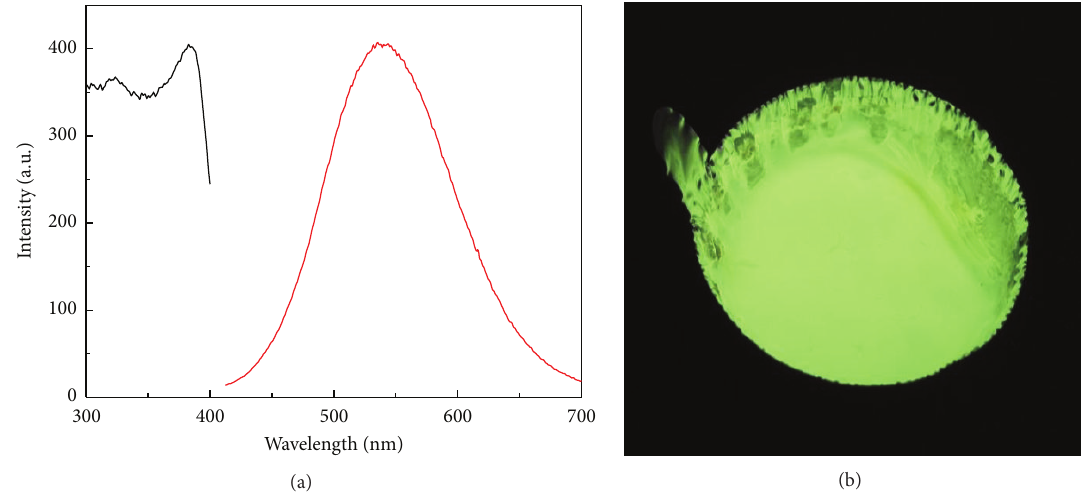
Figure 5: Polystyrene-embedded AuMMI clusters: PL spectrum (a), and sample (3% by weight of AuMMI) under UV-light (365nm) (b).